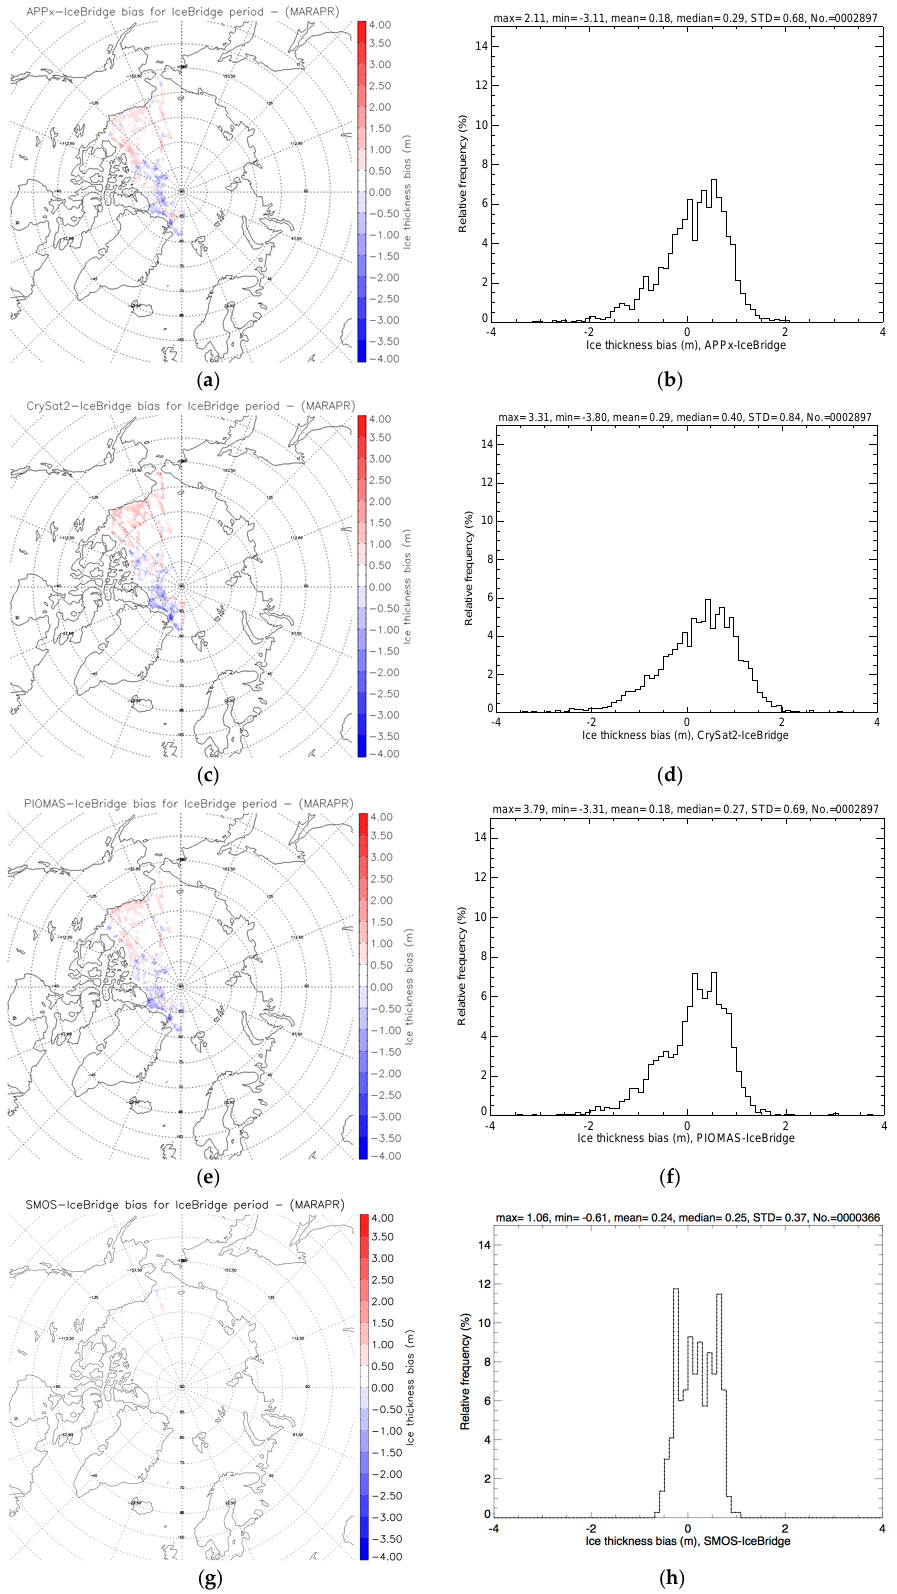
Figure 6. ( a – h ) Comparisons in sea ice thickness from APP-x, CryoSat-2, PIOMAS, and SMOS in terms of IceBridge sea ice thickness for March (MAR) and April (APR), 2011–2013. The bias images for APP-x in ( a ); CryoSat-2 in ( c ); PIOMAS in ( e ); and SMOS in ( g ) are shown on the left, and the bias histograms for APP-x in ( b ); CryoSat-2 in ( d ); PIOMAS in ( f ); and SMOS in ( h ) are shown on the right. The SMOS results are only for IceBridge thicknesses of 1 m and less.